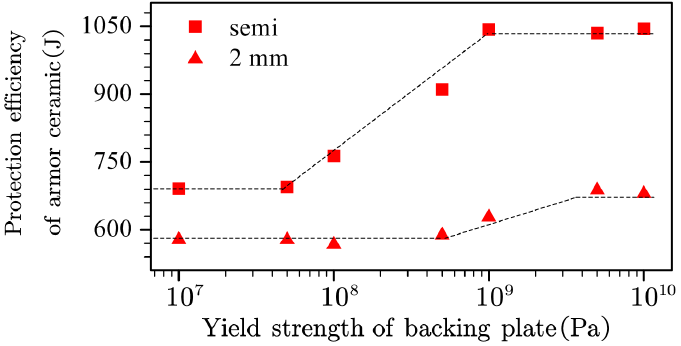
Figure 11. Effect of the yield strength of the backing plate on the armor ceramic protection efficiency. The starting and final values as well as the lower and upper inflection points were all different